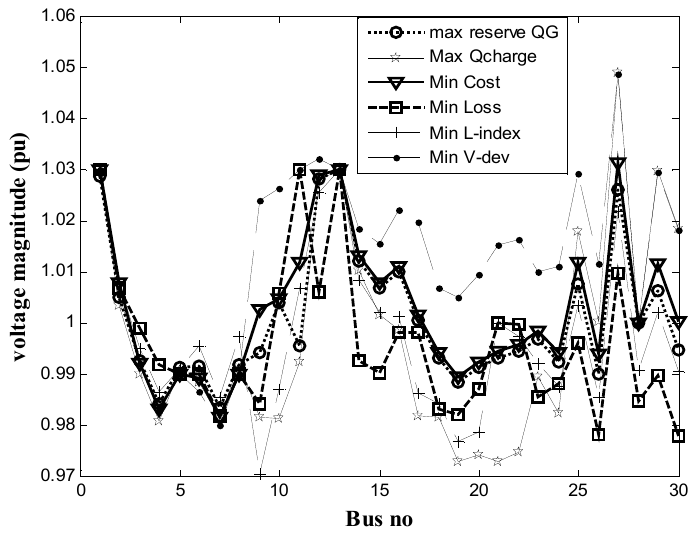
Figure 5. Voltage profile for different objective functions.